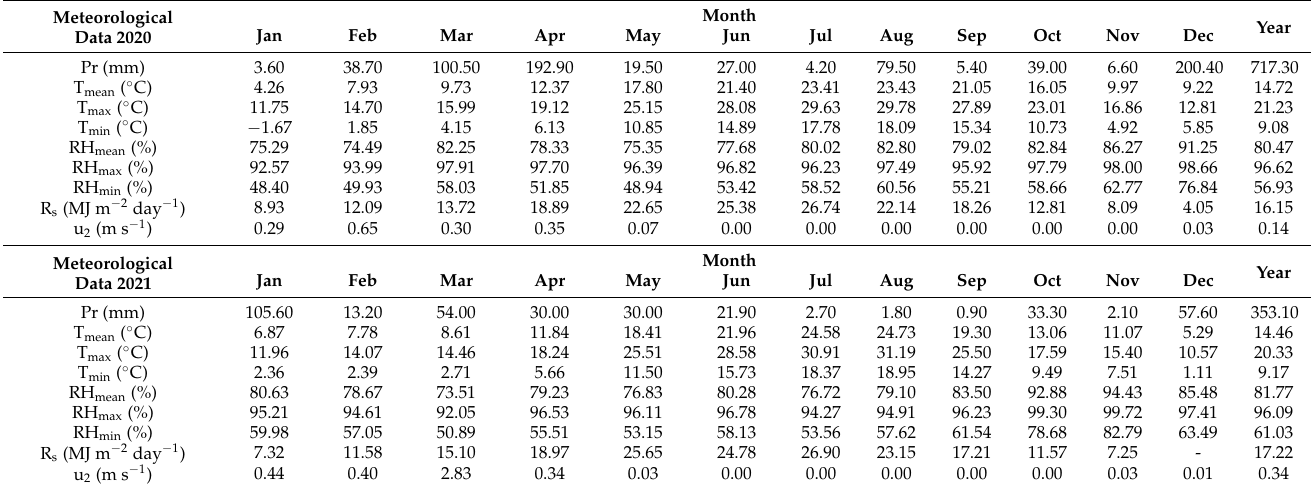
Table 1. Monthly meteorological data of the study area in 2020 and 2021 (Pr: Precipitation; T mean : Mean Temperature; T max : Maximum Temperature; T min : Minimum Temperature; RH mean : Mean Relative Humidity; RH max : Maximum Relative Humidity; RH min : Minimum Relative Humidity; R s : Solar Radiation; u 2 : Wind Speed).